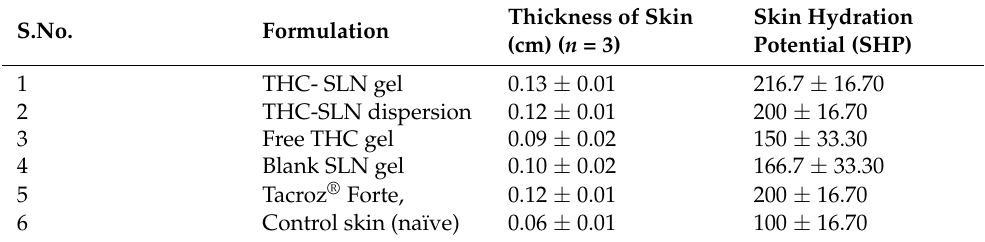
Table 2. Comparative skin hydrating potential after various treatments in Lacca mice. S.No.